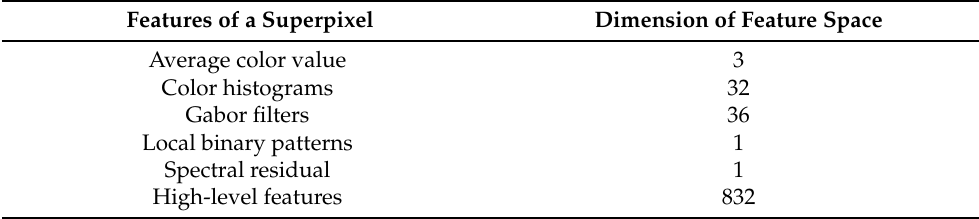
Figure 3. Visualization of convolutional layers: ( a ) input images from the ECSSD dataset; ( b – f ) saliency maps from the outputs of the convolutional layers conv 1-2, conv 2-2, conv 3-4, conv 4-4, and conv 5-4 using the VGGNet-19 [36]. Table 1. The dimension of feature